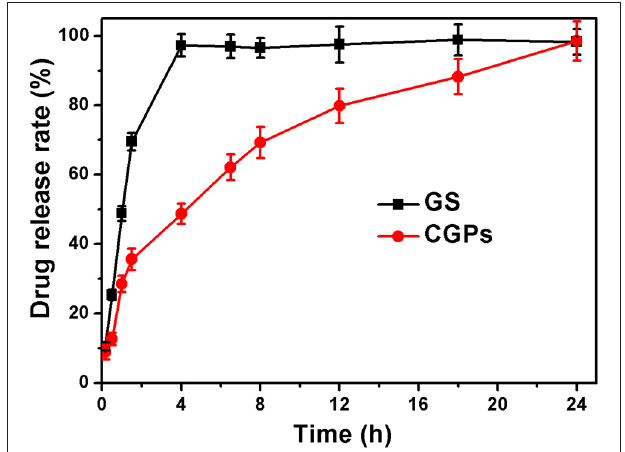
FIGURE 5 | The release profiles with the same initial GS concentration. Data were expressed as mean ± standard deviation ( n = 3).